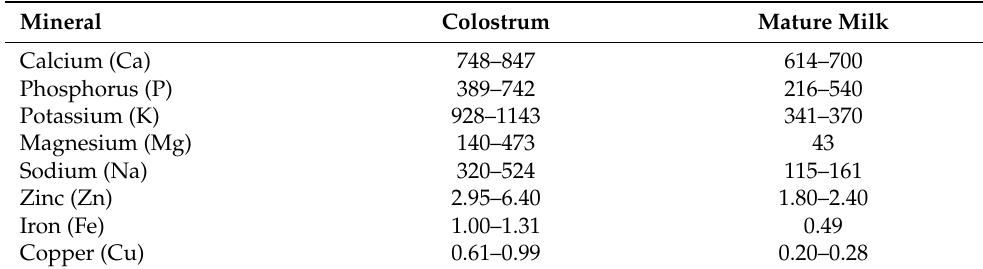
Table 7. Minerals content in mare’s colostrum and mature milk ( µ g/g).